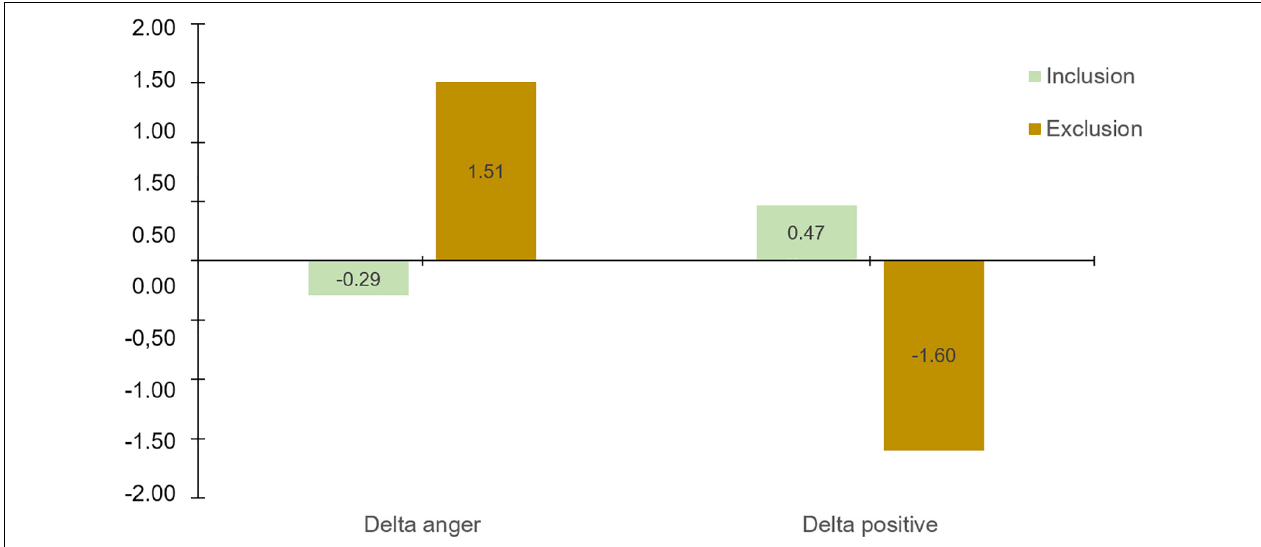
FIGURE 1 | Variation of anger and positive affect in the included and excluded